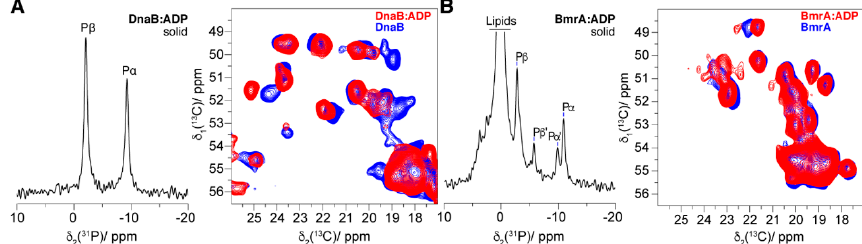
Figure 10. Generation of the post-hydrolytic state using ADP. ( A ) 31 P 1D CP spectrum (left panel) and 13 C- 13 C-DARR the alanine region spectra overlay (right panel) of DnaB:ADP/DnaB apo; ( B ) 31 P 1D CP spectrum (left panel) and 13 C- 13 C-DARR the alanine region spectra overlay (right panel) of BmrA:ADP / BmrA. Spectra ( A ) were adapted from Wiegand et al. 2019 [82] ( http://creativecommons.org/licenses/by/4.0/ .), and spectra in panel ( B ) are original data.